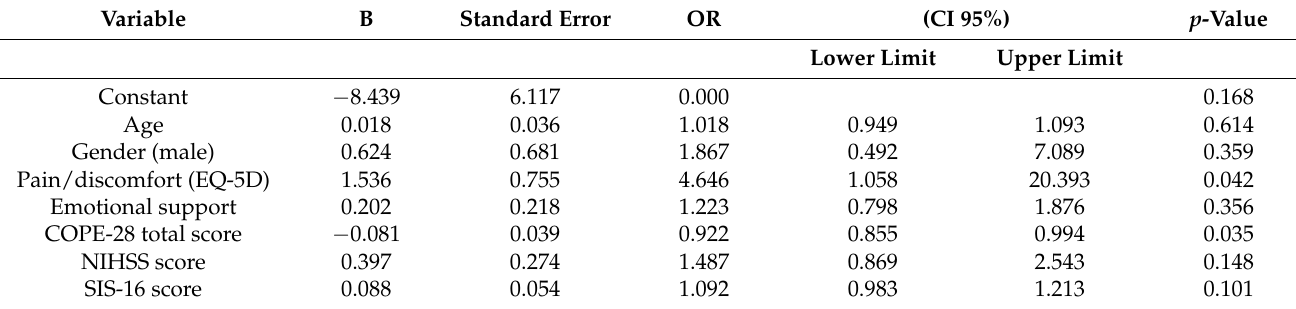
Table 5. Logistic regression model to explain behavioral changes at 1 year after